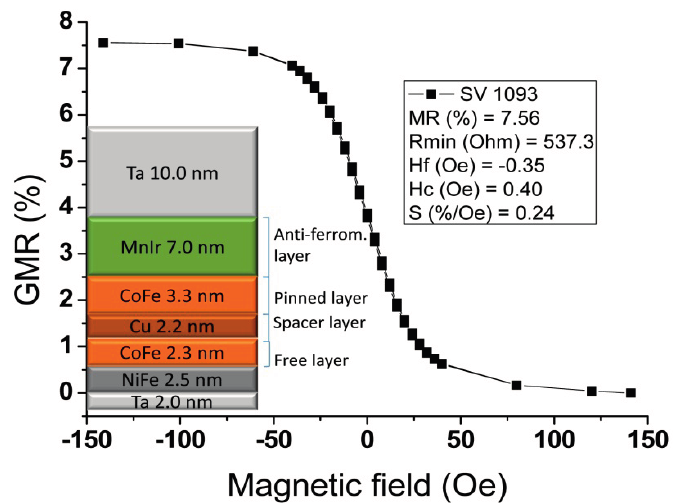
Figure 9. Transfer curve for a selected sensor with an area of 100 × 3 μ m 2 . Inset shows the multilayer structure used for these sensors.